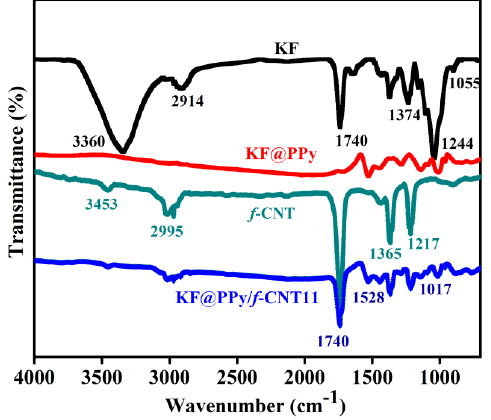
Figure 1. FTIR spectra of KF, KF@PPy, f -CNT, and KF@PPy/ f -CNT11.